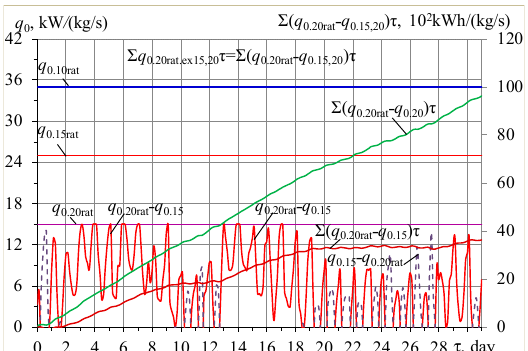
Figure 7. Actual values of rational refrigeration capacity q 0.20rat exceedance q 0.20rat − q 0.15 above q 0.15 and its deficit q 0.15 − q 0.20rat , and summarized monthly refrigeration energy exceedance ∑ ( q 0.20rat − q 0.20 ) τ over q 0.20 and ∑ ( q 0.20rat − q 0.15 ) τ over q 0.15 .